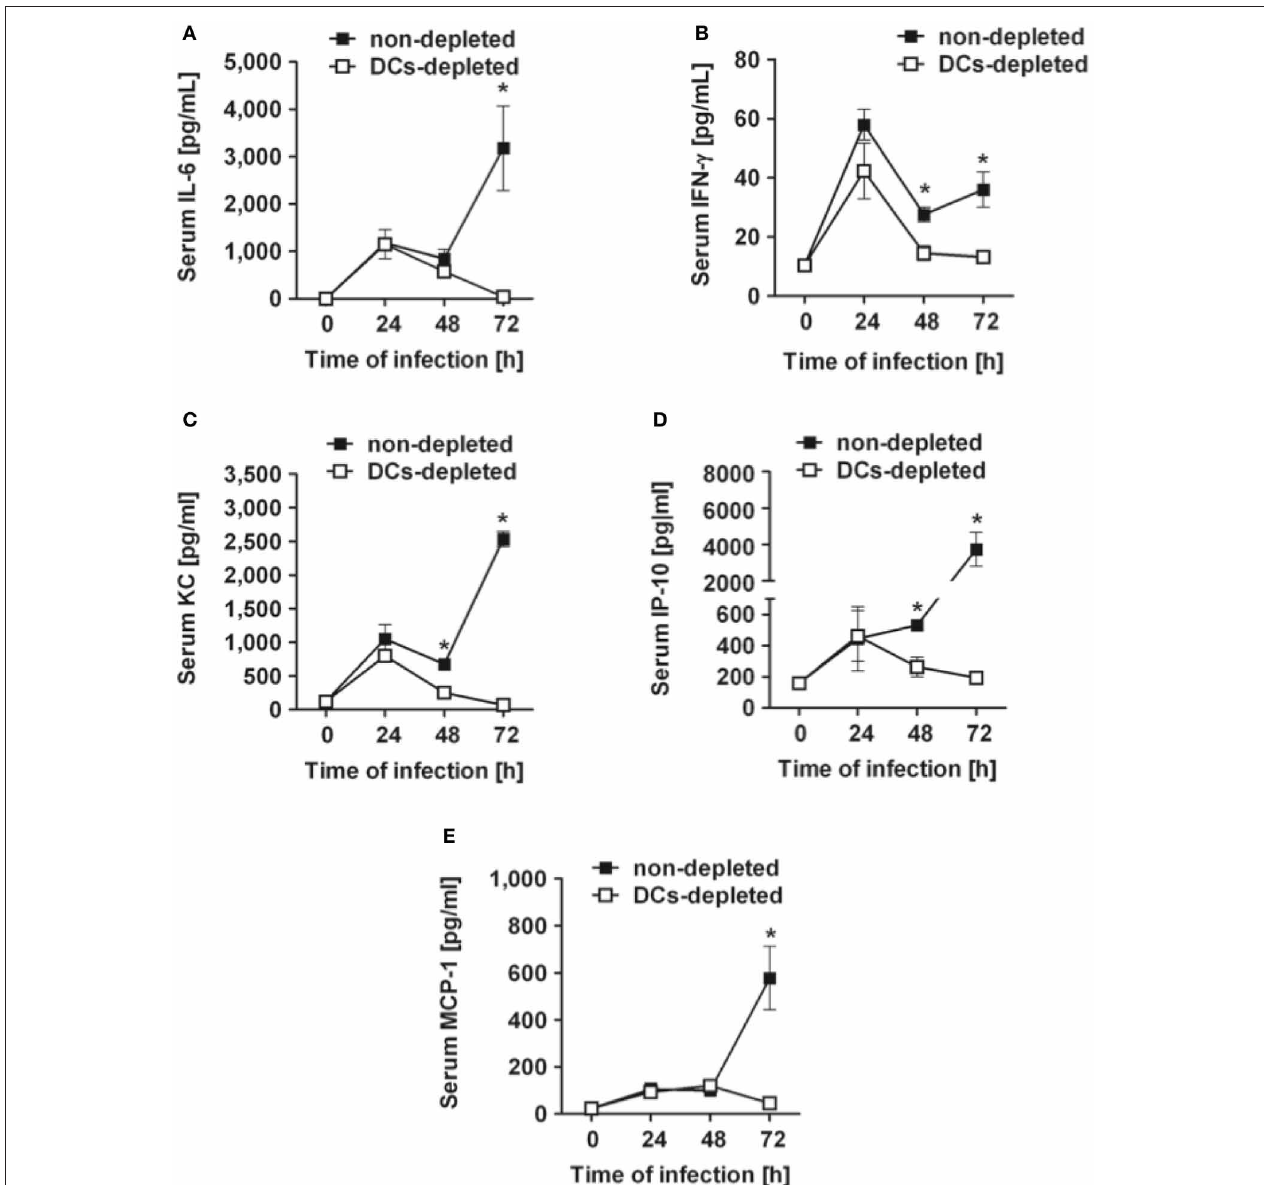
FIGURE 3 | Kinetics of serum cytokines and chemokines in DCs-depleted and non-depleted mice during the course of S. pneumoniae infection. DCs-depleted (white symbols) and non-depleted (black symbols) CD11c-DTR chimera mice were challenged intranasally with 1 × 10 8 CFU of